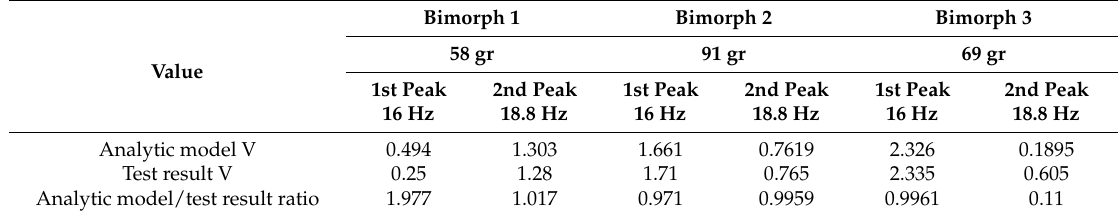
Table 4. Experimental results vs. analytical predictions (parallel electrical connection)—the three bimorphs system.